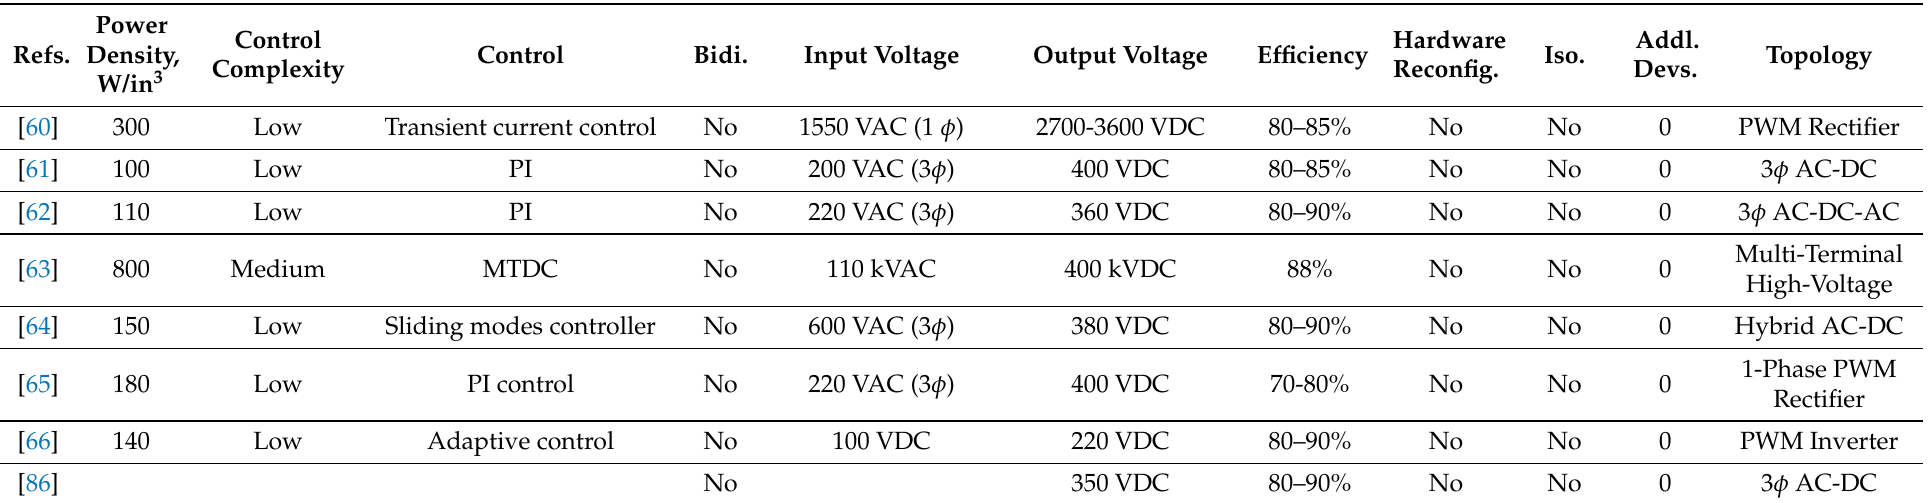
Table 5. Comparison of the different fault-tolerant measurement-level techniques.